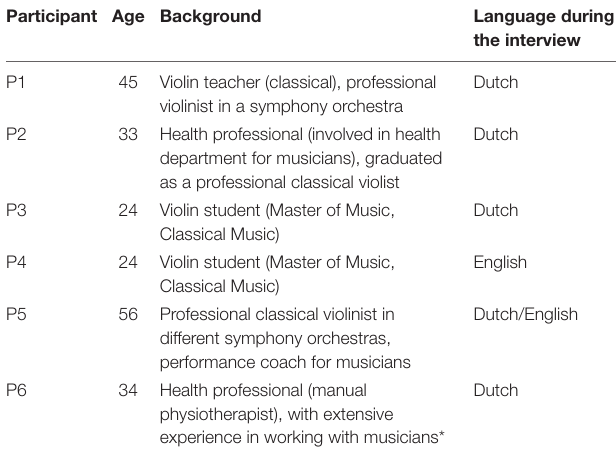
TABLE 1 | Characteristics of the